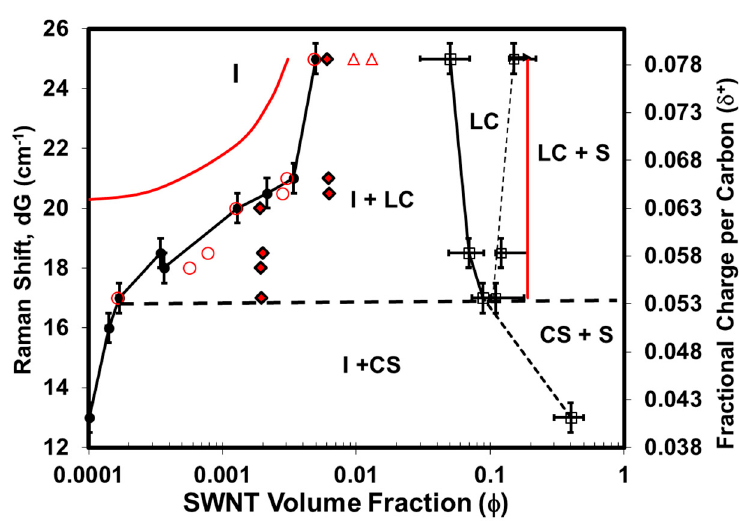
Figure 6. Phase diagram of single-walled carbon nanotubes (SWNTs) in mixtures of varying acid strengths showing isotropic (I), liquid crystal (LC), crystal solvate (CS), and solid (S) phases along with biphasic regions. Solvent quality is quantified by fractional charge per carbon, measured by the shift dG of the Raman G peak of SWNTs (514 nm laser). Onsager predictions for φ I and φ LC in a system of monodisperse hard rods are denoted by open red triangles. Black symbols denote experimental results and red symbols refer to model predictions. Circles designate φ I from experiment (filled circles) and model (open circles). Black and red diamonds indicate the initial system concentration before phase separation. Red lines are the model predictions of the isotropic and liquid–crystalline stability limits (cloud curves). Black dotted lines connect the experimental data points to denote phase boundaries. Modified with permission from Davis, V.A.; Parra-Vasquez, A.N.G.; Green, M.J.; Rai,